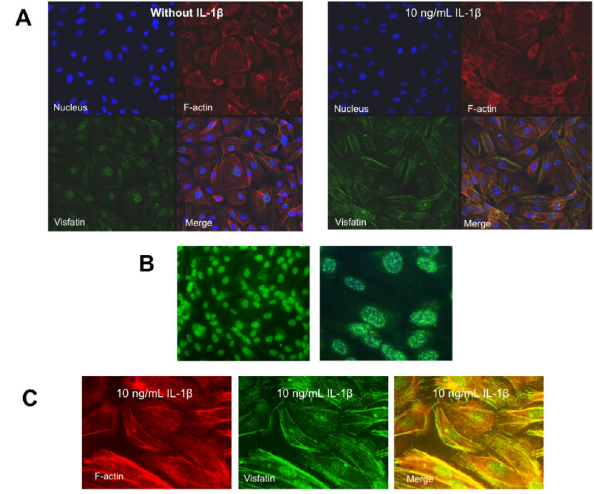
Figure 3. Inflammation modifies the sub-cellular distribution pattern of visfatin in HUVEC. (A) Confocal maximum projections showing a general view of stained nuclei (blue), visfatin (green), F-actin (red), and merge (yellow) in HUVEC cultures. In non-stimulated HUVEC (left), visfatin is mainly localized within the cell nucleus, while in HUVEC stimulated with IL-1β (10 ng/mL) for 18 h (right), visfatin can be markedly found in non-nuclear localizations together with F- actin. 630x magnification. (B) Magnified view of the visfatin granular nuclear distribution in non-stimulated HUVEC at 400x (left) and 1,000x (right) magnification. Nuclei were counterstained with 4'-6-diamidino-2-phenylindole (DAPI).